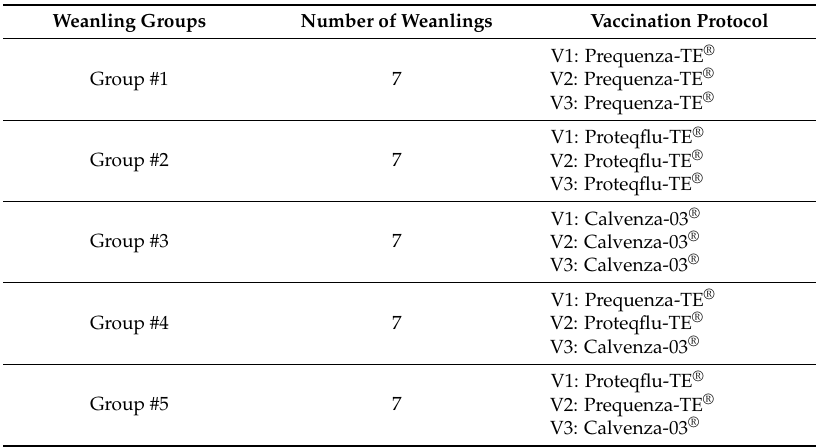
Table 2. Vaccination protocol per